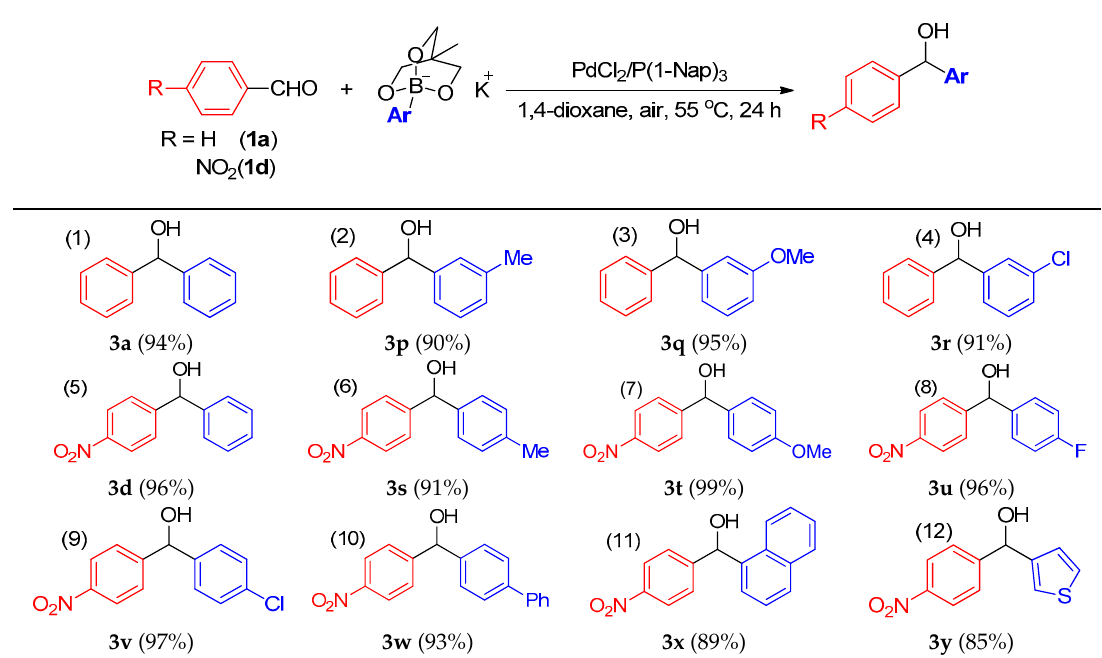
Table 3. Addition of 1a / 1d with various aryltriolborates a .